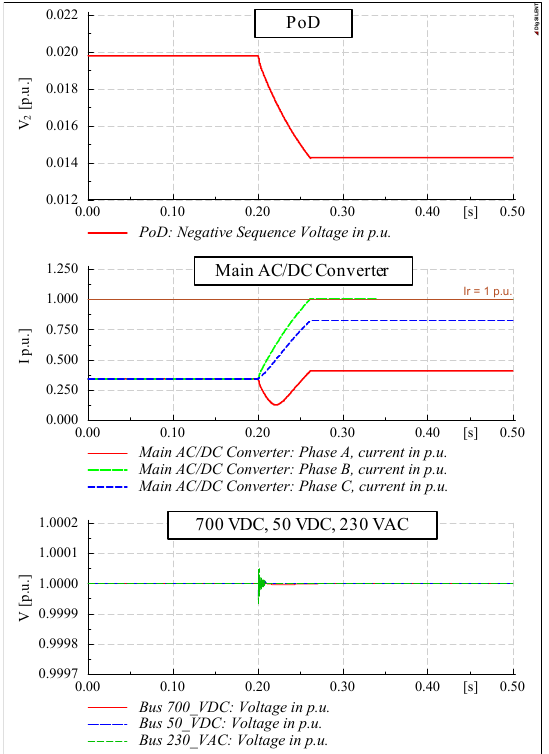
Figure 9. Negative sequence network voltage balancing ancillary service provided by the SST-based end-user.